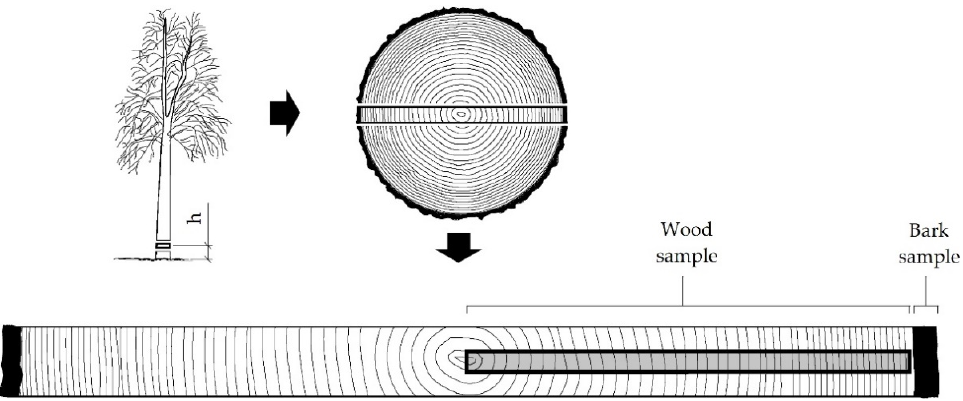
Figure 1. The scheme of sampling (h—breast height diameter (1.3 m)).